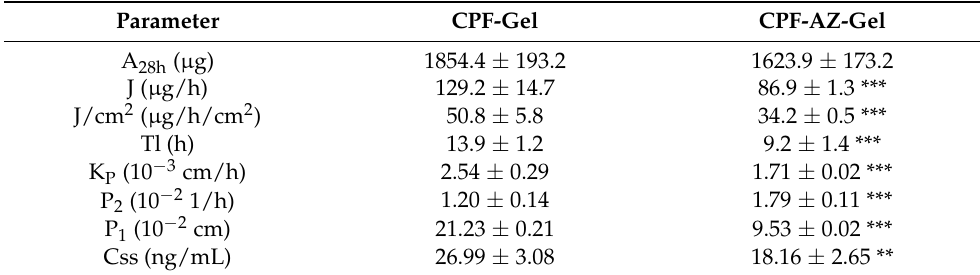
Table 5. Permeation parameters estimated for CPF-gel and CPF-AZ-gel.